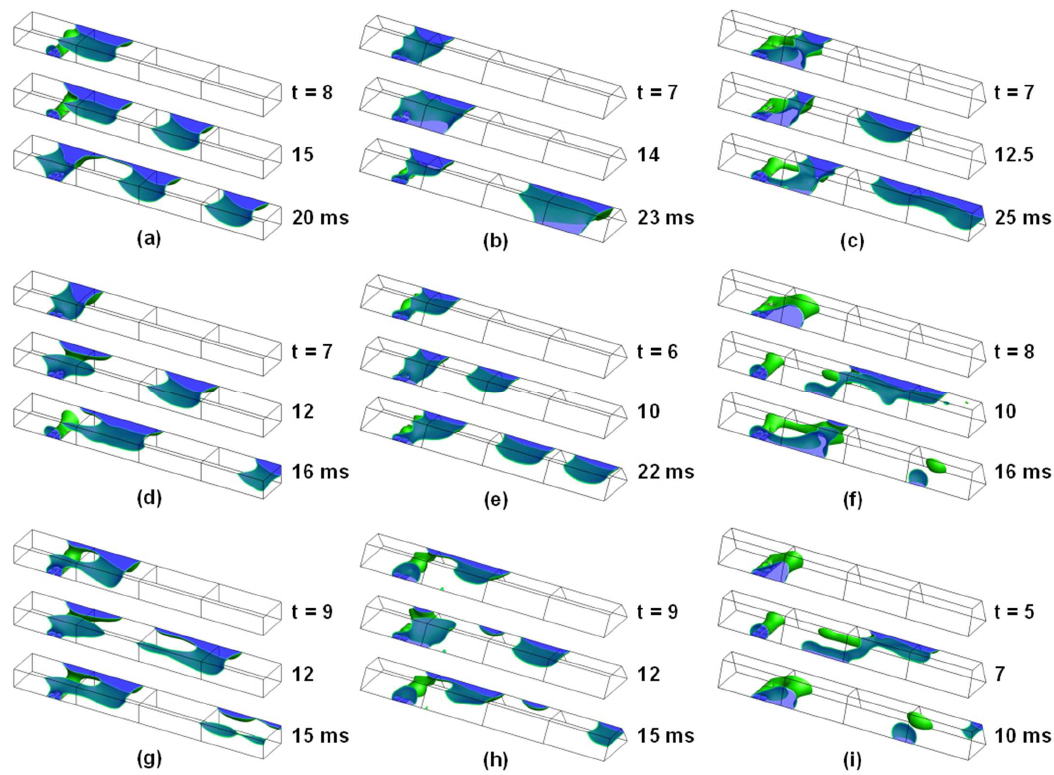
Figure 7 Figure 7. Time evolution of the gas-liquid interface in the GCs ( V in , water = 0.1 m · s − 1 , θ ts = 60 ◦ , θ g = 130 ◦ , H12 water inlet configuration): ( a ) V in , air = 1.0 m · s − 1 (REC); ( b ) V in , air = 1.0 m · s − 1 (T60);